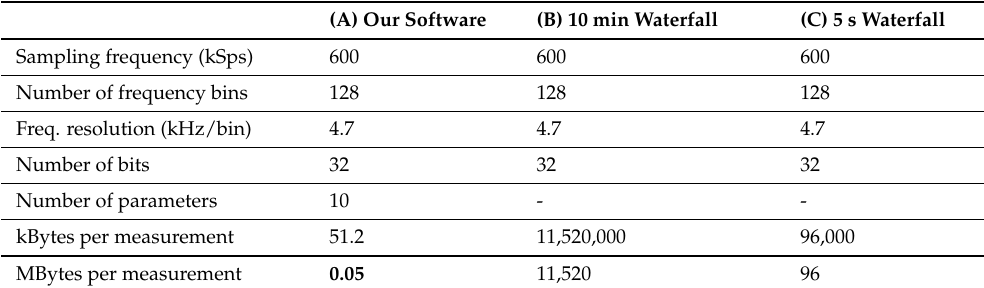
Table 2. Data budget to show how the on-board processing software dramatically reduces the data size to be downlinked compared to standard waterfalls.